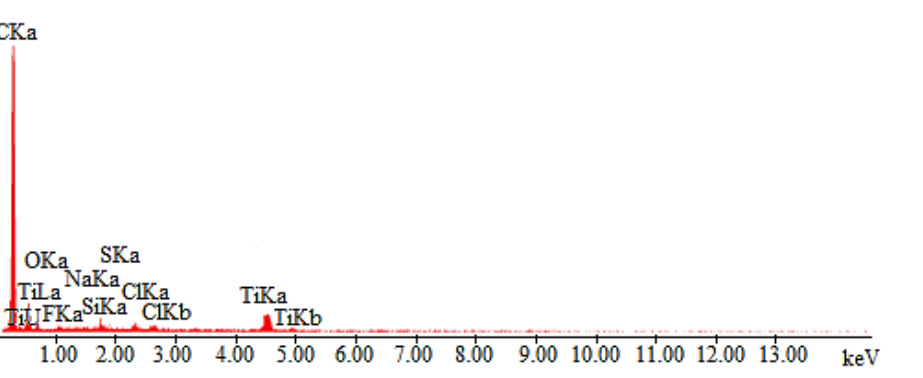
Figure 10. SEM image of Ti-Si coated PROTON fabric at magnification of ( a ) 350×; ( b ) 2000×; ( c ) 10,000×; point “1” is marked for EDS analysis.